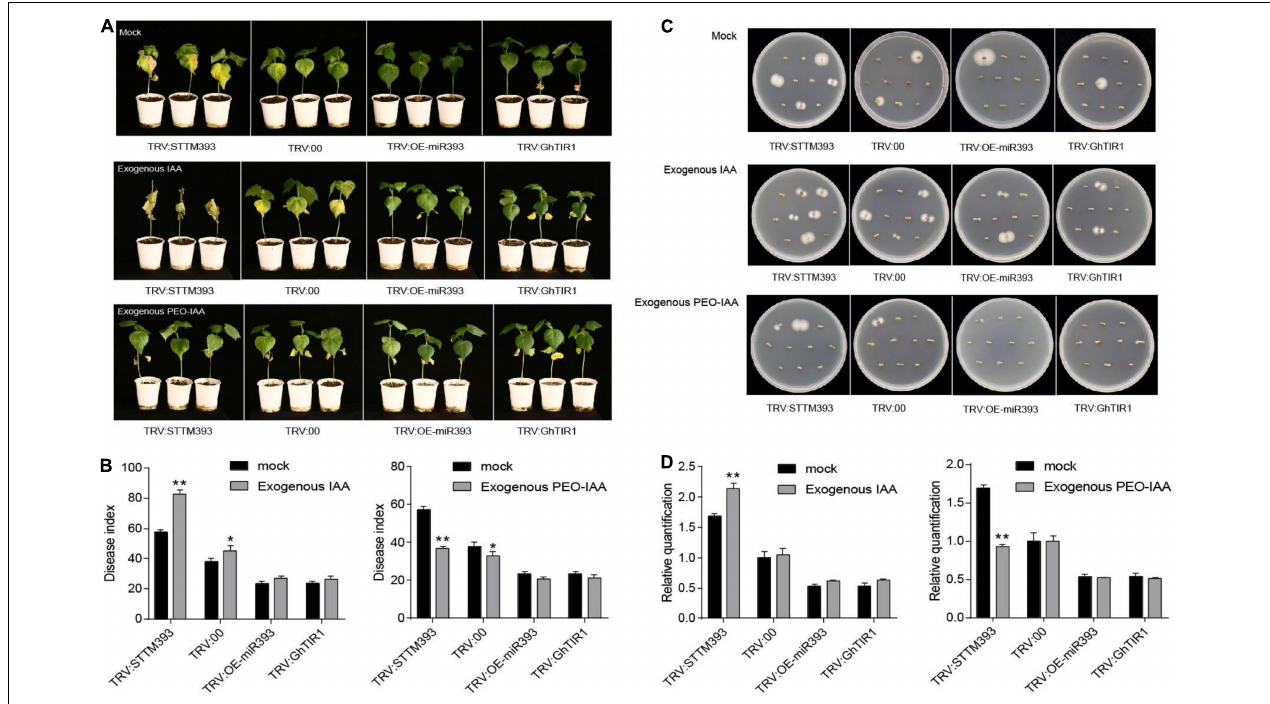
FIGURE 6 | IAA promotes plant susceptibility to Verticillium dahliae infection. (A) The disease symptoms at 21 days of plants inoculated with V. dahliae in which exogenous IAA and PEO-IAA were applied. (B) The disease index of the plants at 21 dpi sprayed with exogenous IAA and PEO-IAA. Statistical significance as compared with TRV:00 was determined by Student’s t -test: * P < 0.05, ** P < 0.01. (C) Fungal recovery assays. (D) Relative V. dahliae fungal biomass in the infected stems. The error bars indicate the SD of three biological replicates. Statistical significance was determined by Student’s t -test: ** P <